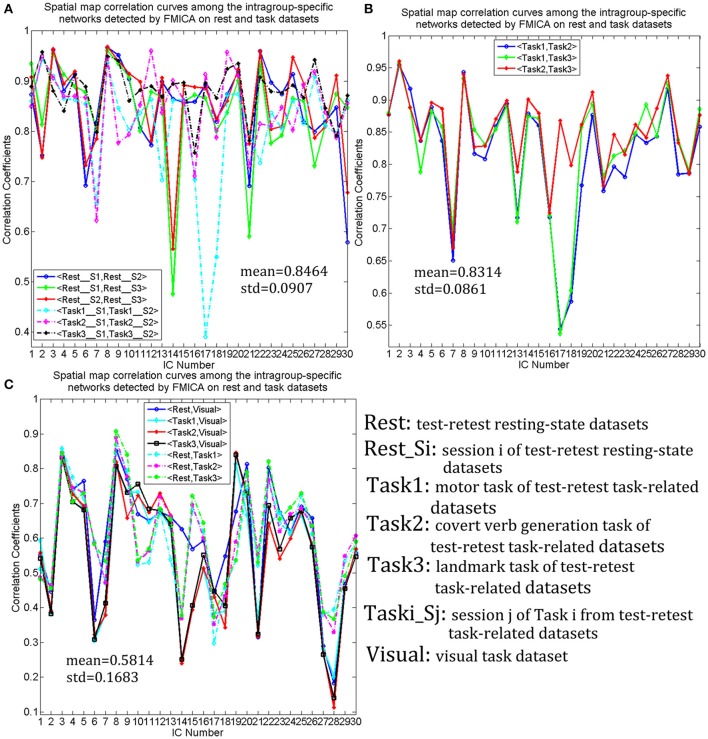
The spatial correlation curves of the intragroup-specific BFNs generated by FMICA among the test-retest resting-state datasets, three test-retest task-related datasets and visual task dataset: (A) the spatial map correlation curves among the intragroup-specific BFNs from the same kinds of datasets with different sessions; (B) the spatial map correlation curves among the intragroup-specific BFNs with respect to the test-retest task-related datasets; (C) the spatial map correlation curves among the intragroup-specific intrinsic BFNs from different kinds of datasets.